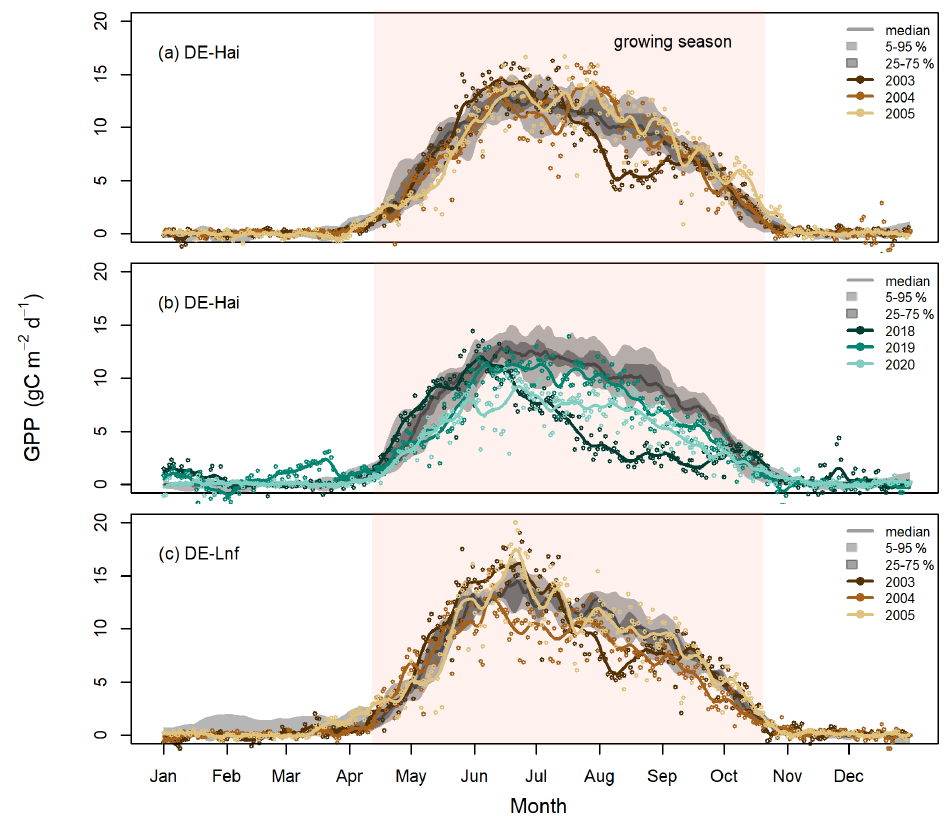
Figure 2. Daily GPP in the selected drought and legacy years at (a) DE-Hai 2003, (b) DE-Hai 2018, and (c) DE-Lnf 2003, showing the droughts and following legacy years, respectively. Coloured points and lines show the original and smoothed (7d average) GPP, respectively, in drought and legacy years. The grey lines and shaded areas show the median, 25th–75th (dark grey), and 5th–95th (light grey) percentiles of GPP, respectively, over non-drought and non-legacy years. The shaded coral areas indicate the average growing seasons of DE-Hai and